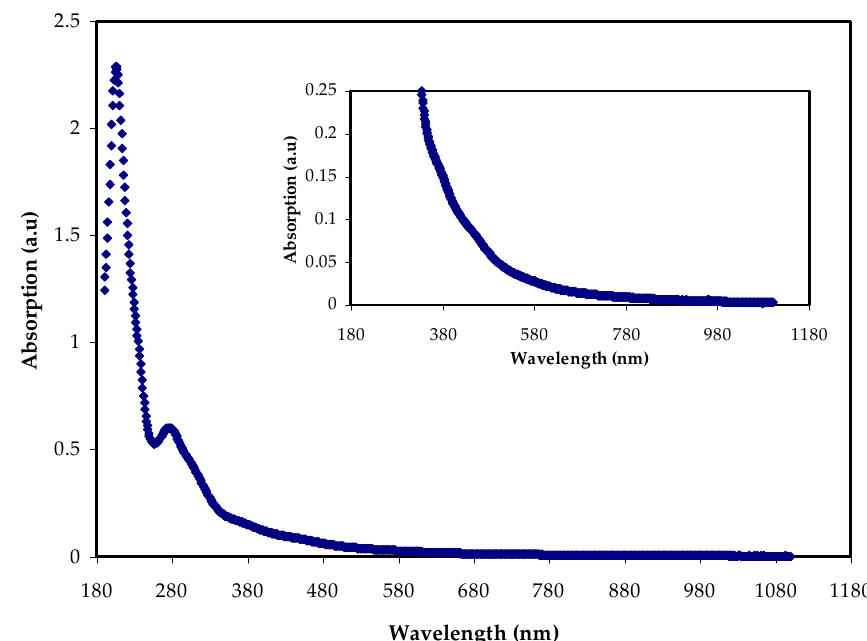
Figure 1. UV-visabsorption spectrum for Sn 2+ -PPHs metal complex. The transition of electron of n −π * of methylxanthines, catechins, and caffeine emerges as an absorbance band between 200 and 350 nm. The C=O chromophore in caf- feine has a band absorbance of 278 nm [22,23]. Surface plasmon resonance (SPR) absorp- tion band in UV-visible range is required for metallic’s with diameters in the nano range [24]. Nevertheless, the lack of this band in the current Sn 2+ -PPHs complex suggests that the PPHs capping inhibited the complex system’s metal properties from forming on par- ticle surfaces. Cu NPs in chitosan-based PEs produce an SPR band in the region of 500 and 800 nm, according to earlier study [25]. 3.2. FTIR Studyof BTand Sn 2+ -PPHs Metal Complex The FTIR spectra of the extracted BT’s are shown in Figure 2a. The emergence of many peaks is viewed as the FTIR spectrum’s main characteristic. The C-H stretching of carboxylic acid and aliphatic group is responsible for the current peaks in the range of 2913–2847 cm − 1 [26].The existence of a band at 1623 cm − 1 could also be used to identify the aromatic ring’s C=C stretch [16,19,26]. It is worth mentioning that the existing FTIR spectrum’s overall characteristics match those found in prior investigations [27,28]. The caffeine spectrum has recently been discovered to feature several changes in the range between 1700 and 400 cm − 1 (Figure 2a). The existence of a range of functional groups with stretching and binding movements, for instance carbonyl, methyl, imidazole, and py- rimidine fragments, can be seen in these changes [29]. The key functional groups in tea, as shown by the FTIR spectra, are PPHs, carboxylic acid, and amino acids. PPHs have been demonstrated to interact with the metal cation to produce colloidal metal-PPHs complex solutions, according to the literature [30].